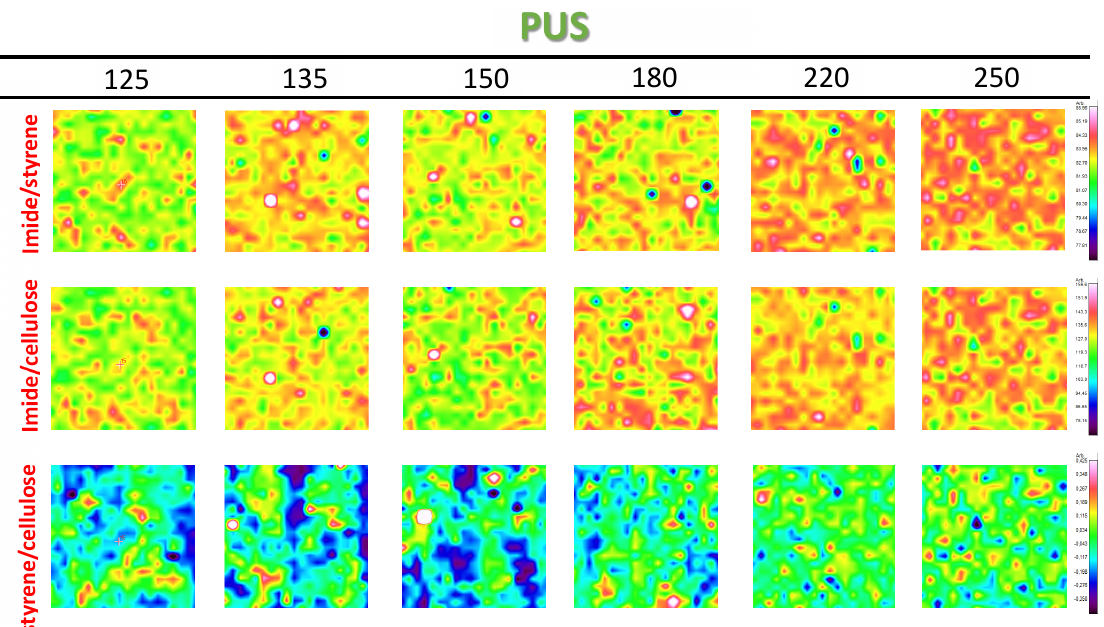
Figure 11. Raman spectroscopy surface maps of SMI/SfO-PUS coatings (1 × 1 mm 2 ), representing band intensity ratio of imide/styrene, imide/cellulose, styrene/cellulose (same intensity scale per